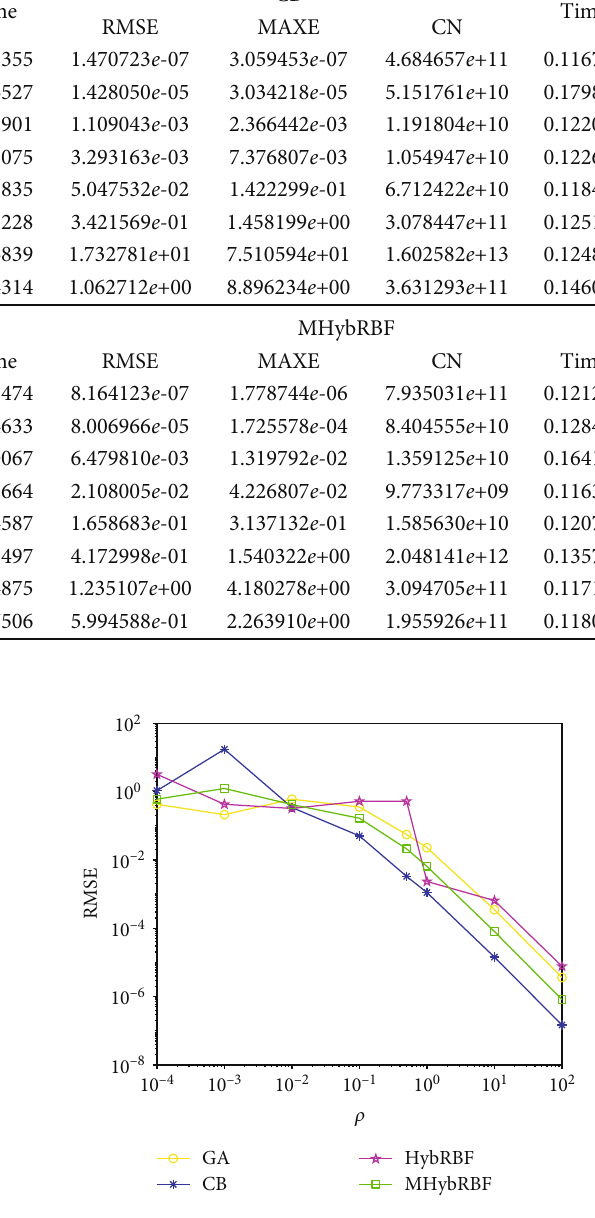
Table 2: Comparison of results obtained by applying the RBF collocation method with GA, CB, HybRBF, and MHybRBF with di ff erent ρ . ρ GA